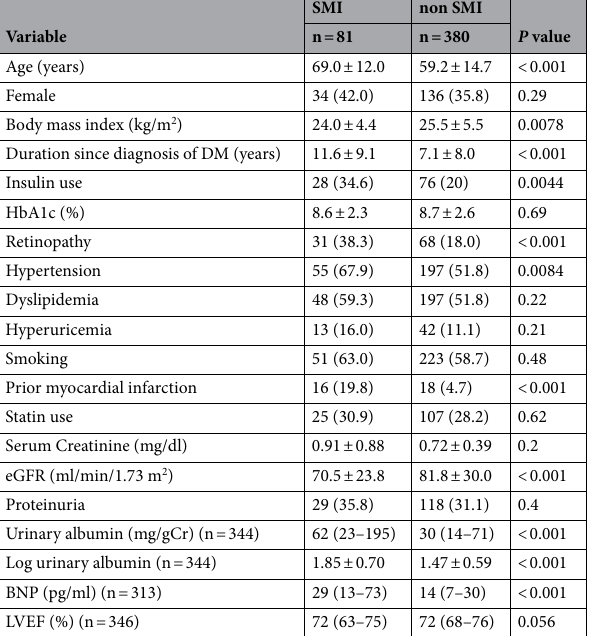
Table 1. Baseline Clinical Characteristics between SMI vs. non SMI in DM. Data are expressed as n (%), the mean ± standard deviation (SD) or median (interquartile range); eGFR, estimated glomerular filtration; BNP B-type natriuretic peptide; LVEF left ventricular ejection fraction.